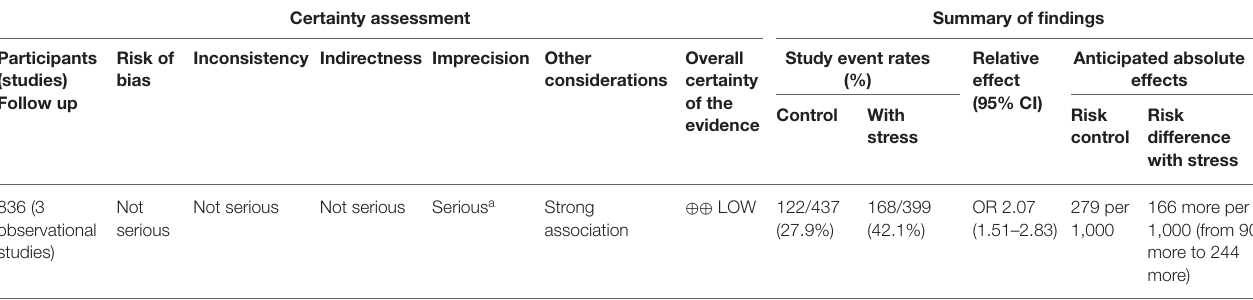
TABLE 3 | The certainty of evidence: association between stress and bruxism. Certainty